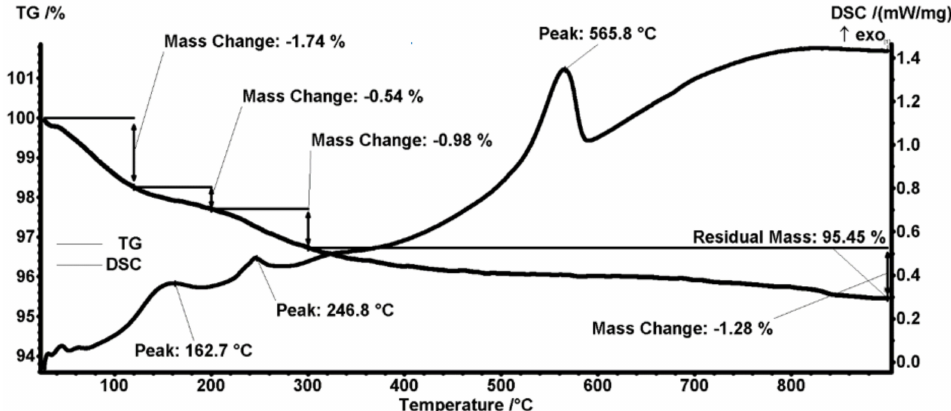
Figure 4. Thermogravimetric analysis of Fe 3 O 4